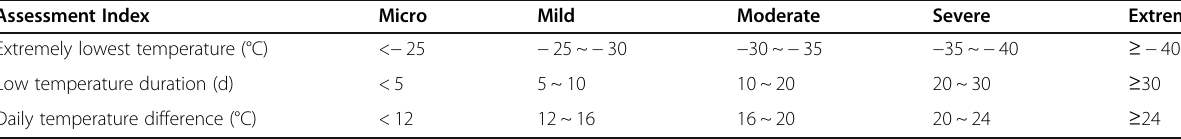
Table 2 Assessment standard of extreme low temperature climate in cold regions Assessment